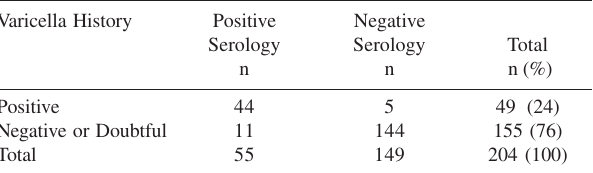
Table 2 - Distribution of children included in the study (n) according to their parents’ information on varicella history and serological response. São Paulo Municipality, August